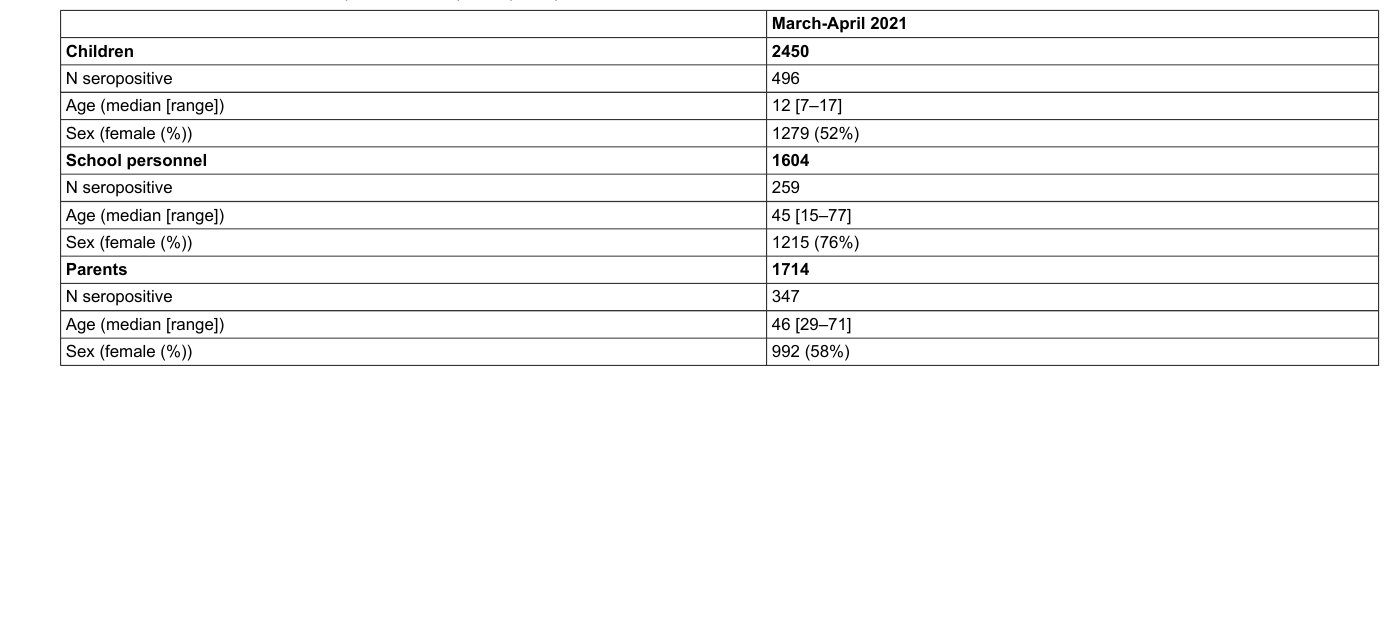
Table S1: Characteristics of the children, school personnel and parent participant